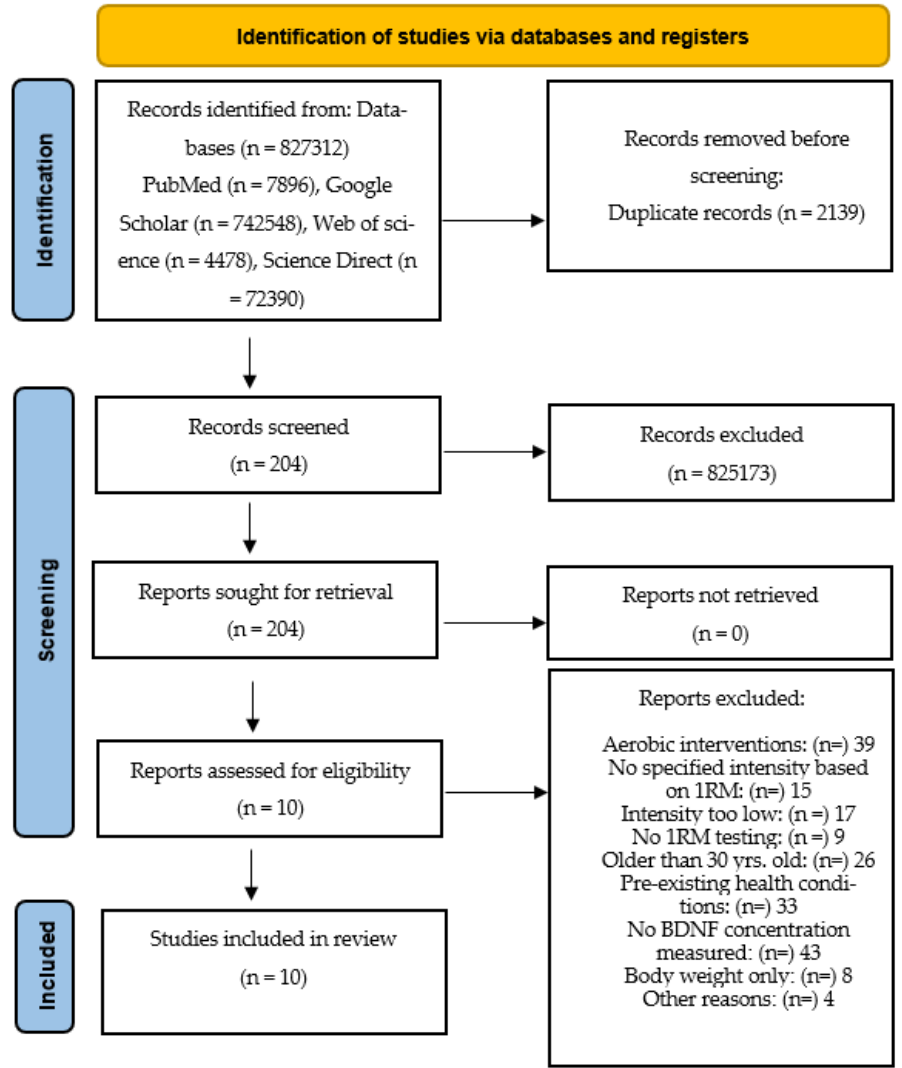
Figure 2. Flowchart providing information on the search, screening and selection processes that led to the identification of relevant articles included in this systematic review.